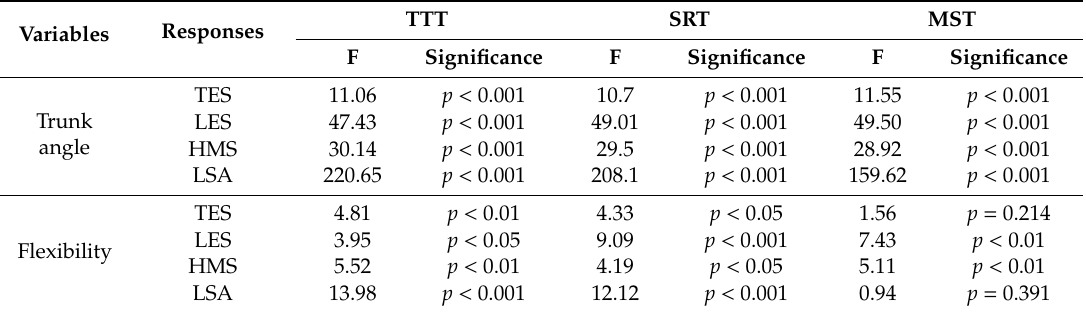
Table 4. Main e ff ects of the variables for three flexibility measurements based on a 2-way ANOVA.